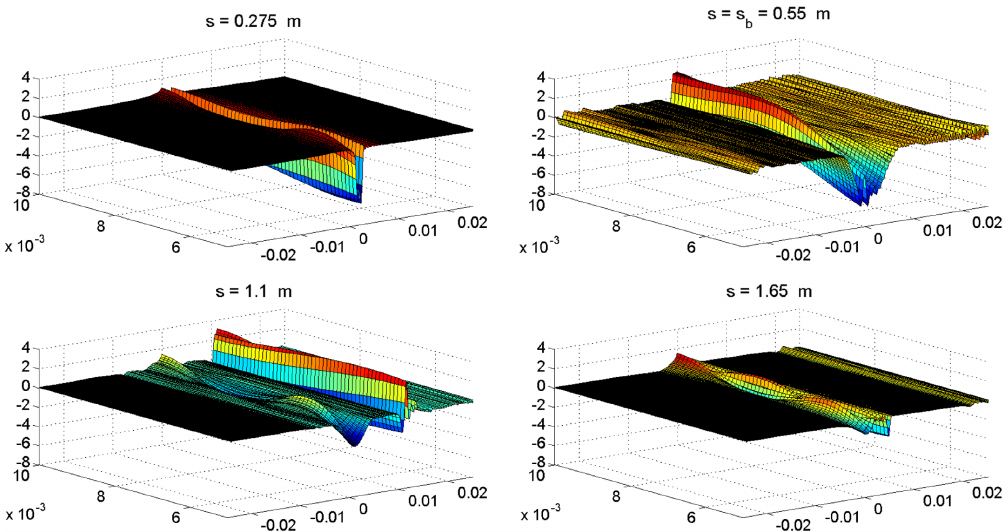
s; x; y; t Þ as a function of ð x; y Þ at the instant the bunch is at location s . Plots in the upper 1 = 4 of the FIG. 17. Surface plots of H x ð chamber only, in arbitrary units. The ð x; y Þ -domain is the same as that in Fig.